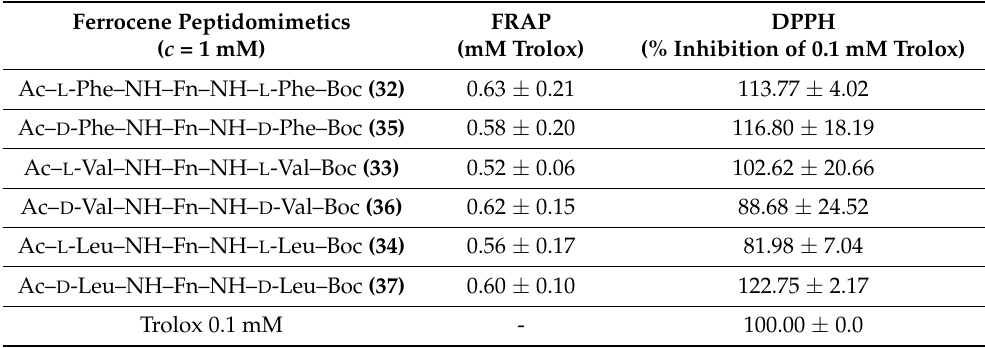
Table 3. Antioxidant activity of ferrocene peptides evaluated by 1,1-diphenyl-2-picryl-hydrazyl radical scavenging assay (DPPH) and ferric reducing antioxidant power methods